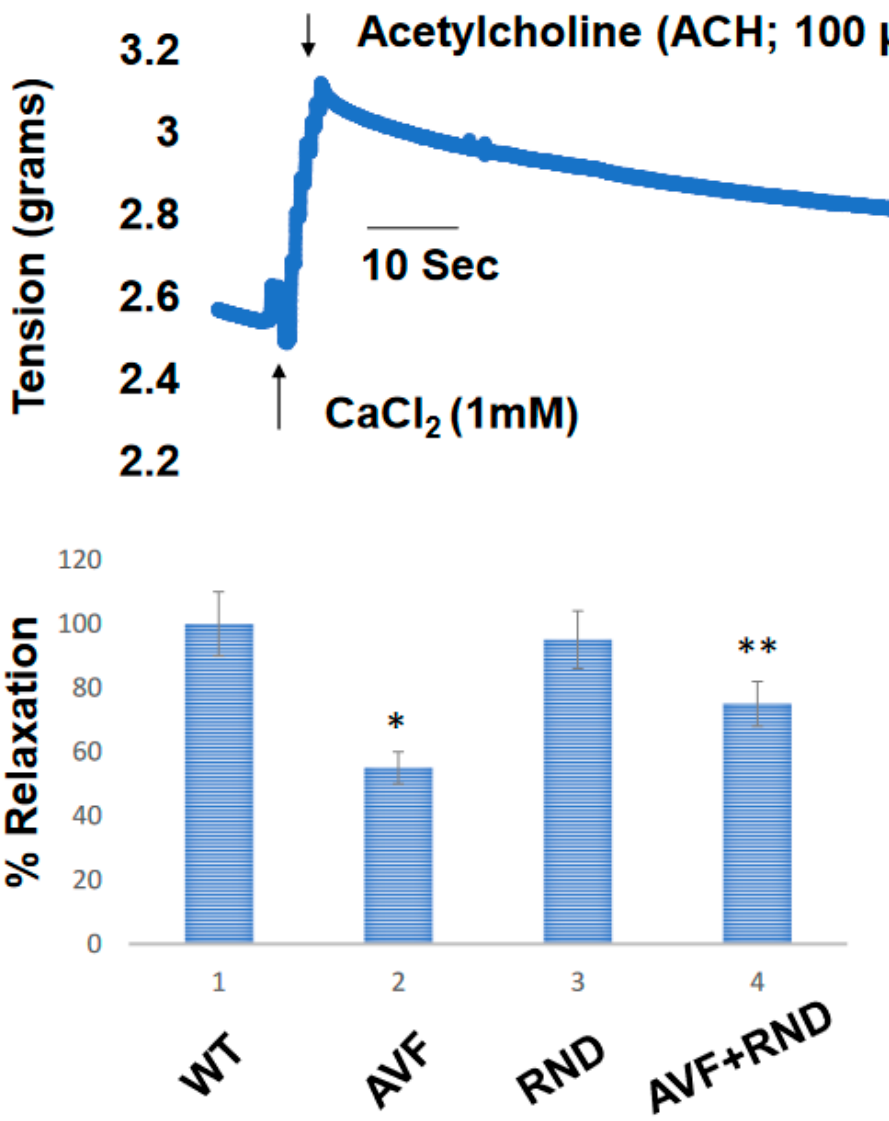
Figure 3. Cardiac endothelial dependent endocardial endothelial function measured in cardiac left ventricle (LV) ring prepared from C57BL/6J WT-control, AVF, RND, and AVF-RND male mice at 16 weeks. The rings were contracted with CaCl2 (1 mM), and acetylcholine was added to relax the cardiac rings. The bar graph represents the percent relaxation from CaCl 2 (1 mM) contraction by 100 µ M acetylcholine (ACH). The mean ± SD from n = 5; *, p < 0.05 compared to WT; **, p < 0.05 compared with